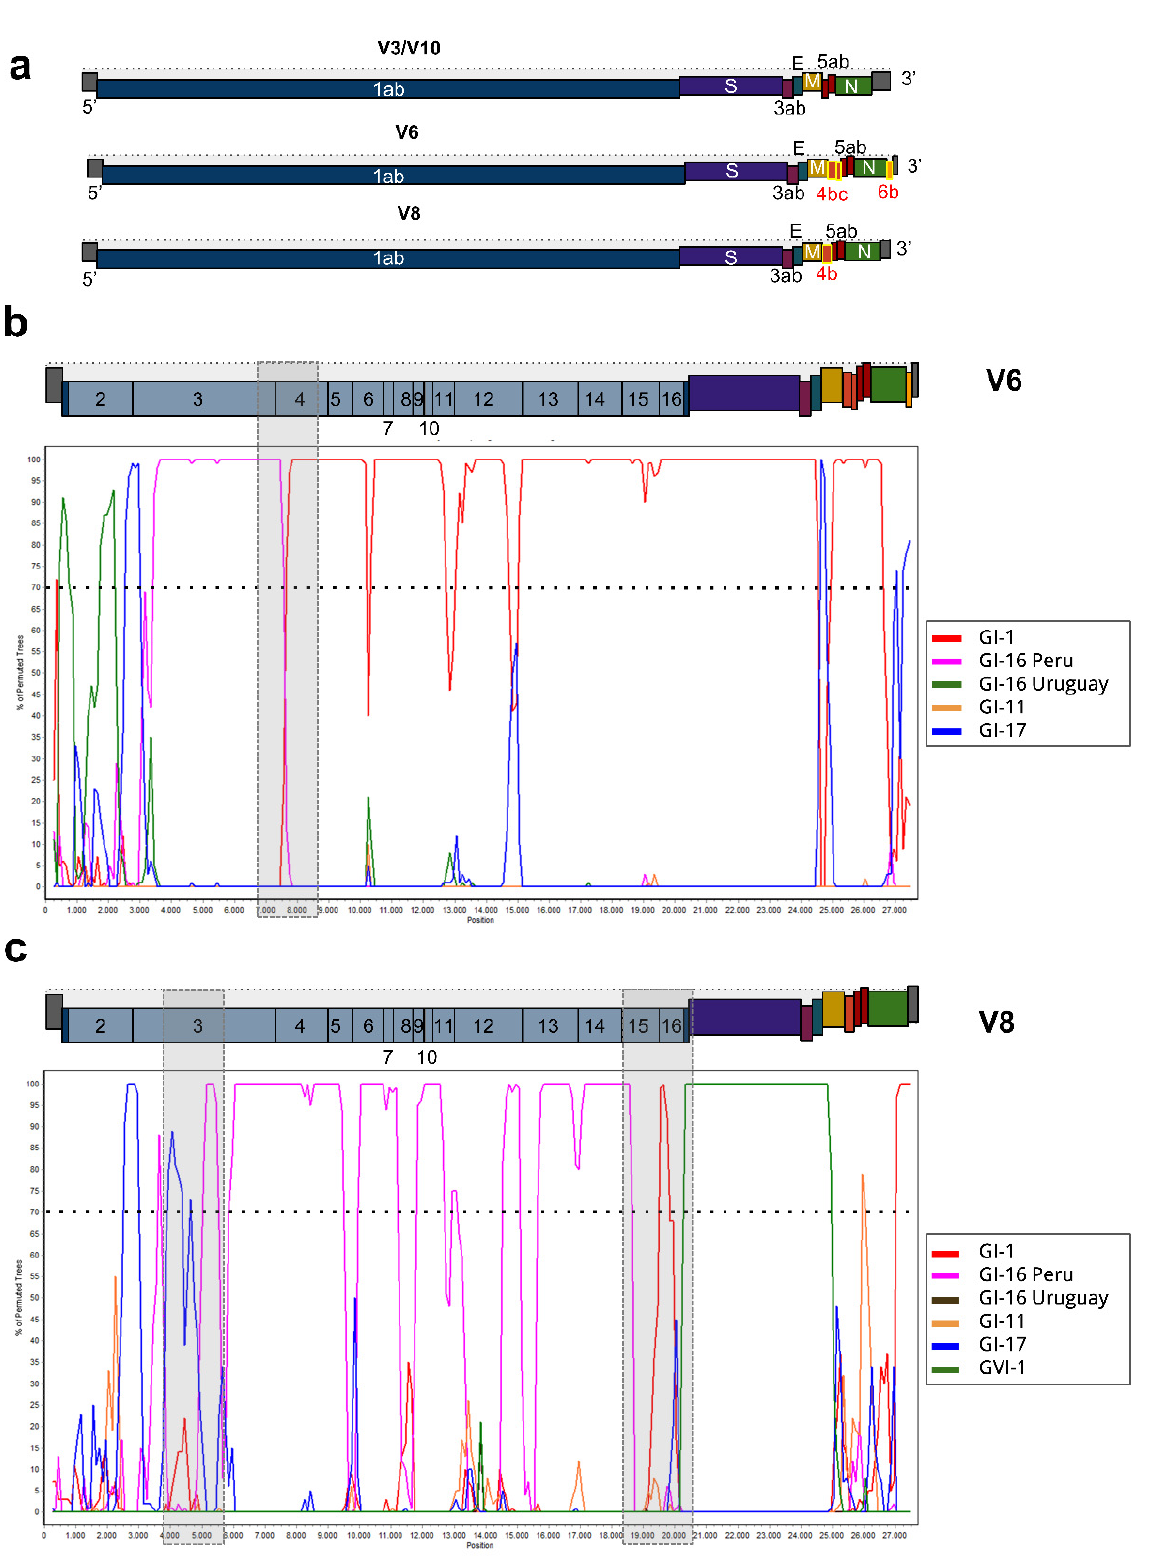
Figure 5. ORF prediction and recombination analyses. ( a ) Genomic organization of V3, V10, V6, and V8. Red labels and yellow boxes highlight variation regions in detected ORFs. ( b ) and ( c ) Bootscan analysis (Simplot 3.5.1) of V6 and V8 whole genome sequences, respectively (windows size: 500 bp, step size: 100 bp). The dotted lines indicate a bootstrap value of 70%, and gray boxes indicate regions with recombination events. All strains analyzed in this study show a non-recombinant profile in the S1 region. The complete genome recombination analysis suggests that V2, V3, V5, V9 and V10 strains do not present recombination events, clustering in all its extension with reference strains of the GI-1 lineage. Furthermore, this analysis indicates that V6 and V8 present mosaic